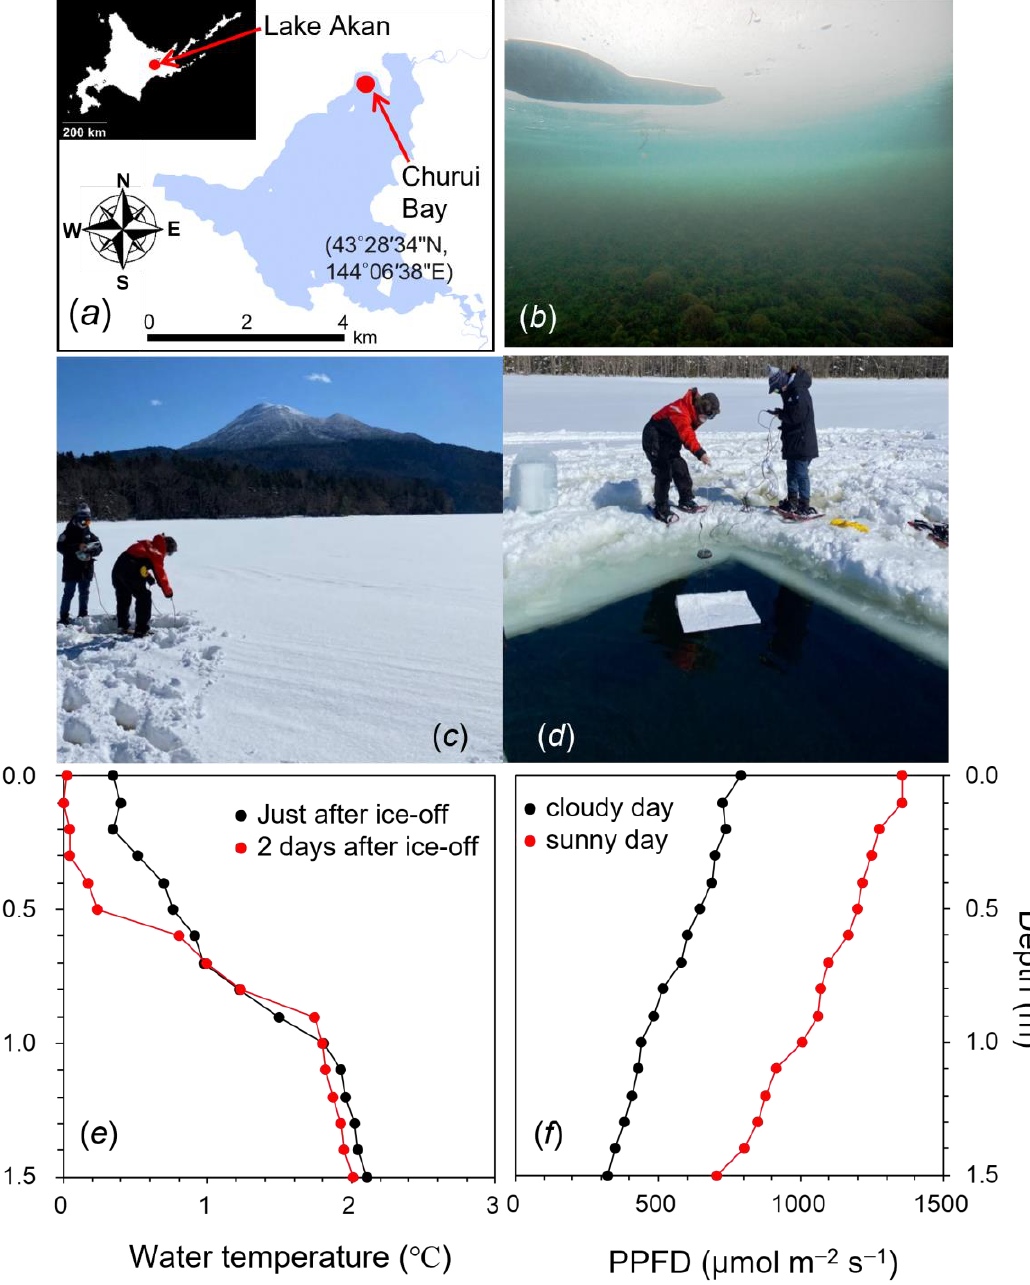
Figure 1. ( a ) Sampling location in Lake Akan, Hokkaido, Japan. ( b ) Marimo in Lake Akan. ( c ) Ice on the surface of Lake Akan in the winter. ( d ) Cutting out a part of the ice of the lake. ( e ) Vertical profile of the water temperature just after the ice-off (black) and two days after the ice-off (red). ( f ) Vertical profile of PPFD under the lake without the ice on cloudy (black) and sunny days (red). Measurements were conducted on a clear day in March. Ice thickness was about 50